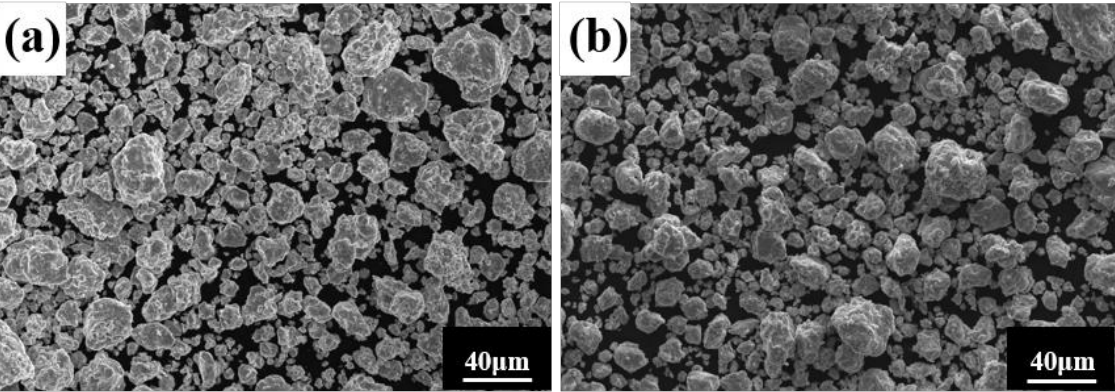
Figure 5. Powder microstructures at different milling times with the a milling speed of 500 r min −1 and ethanol PCA: ( a ) 30 h; and ( b ) 60 h.